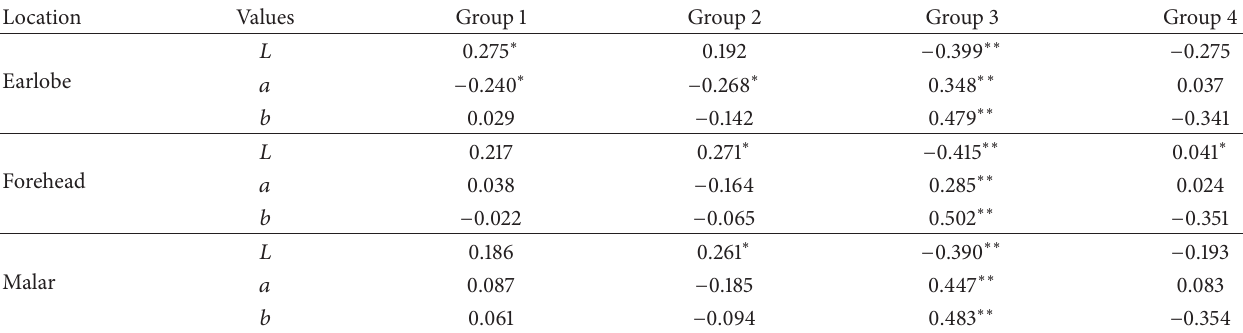
Table 3: Pearson’s correlation coefficient matrix of teeth and skin colour at different